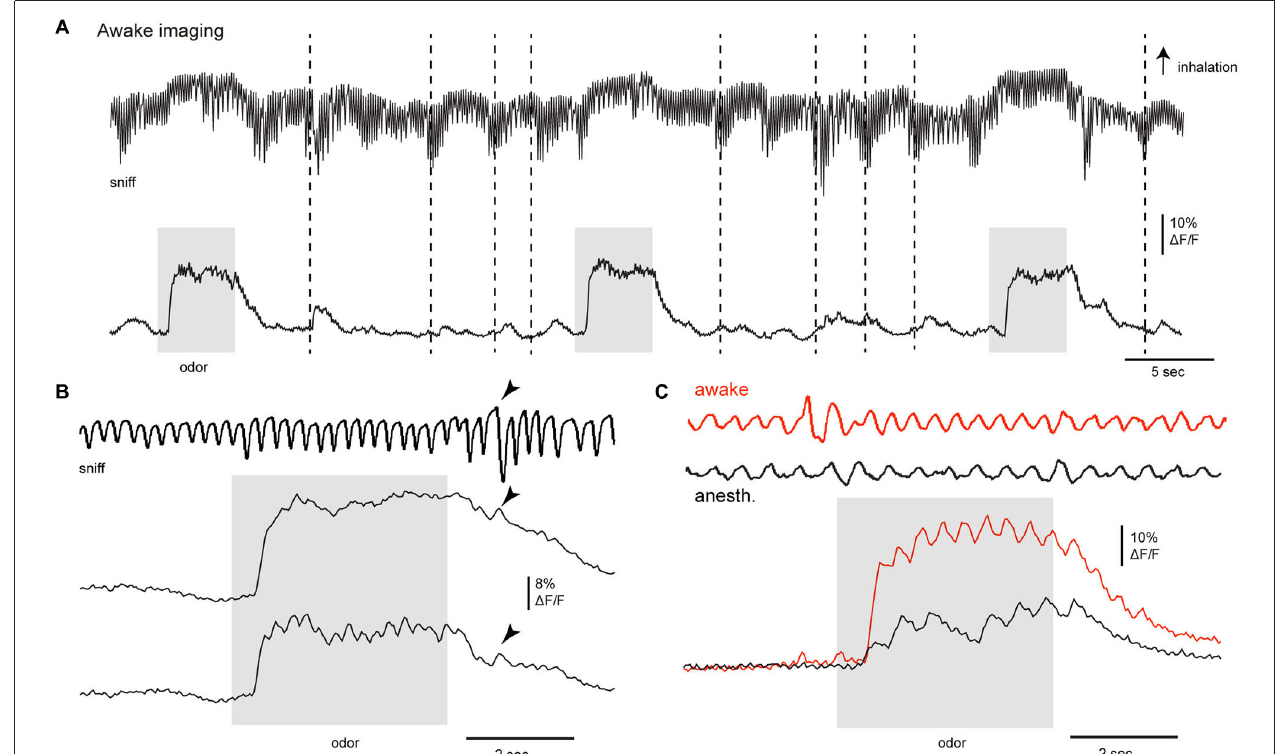
times; activity from one ROI is displayed. Top trace in (A, B and C) shows respiration measured via thermocouple (placed in front of the nose in the depicted example), with inhalation up in all cases. Stippled lines indicate bouts of higher frequency sniffing; arrowhead points to a single deep inhalation. Odorant application as well as high-frequency sniffing in the absence of odorants activated AON inputs as reported with GCaMP3.